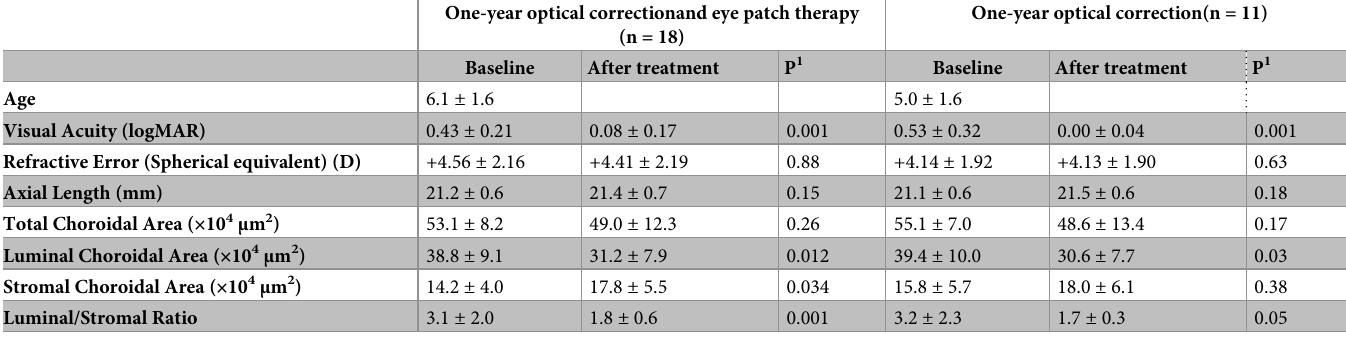
Table 3. The amblyopic eye of the amblyopic patients before and after one-year treatment.